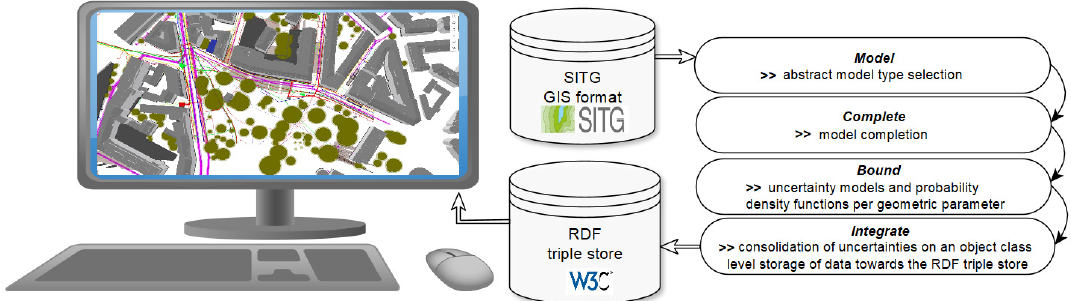
Figure 5. Data work flow from Geographical Information System (GIS) store to resource description framework (RDF) triple store.